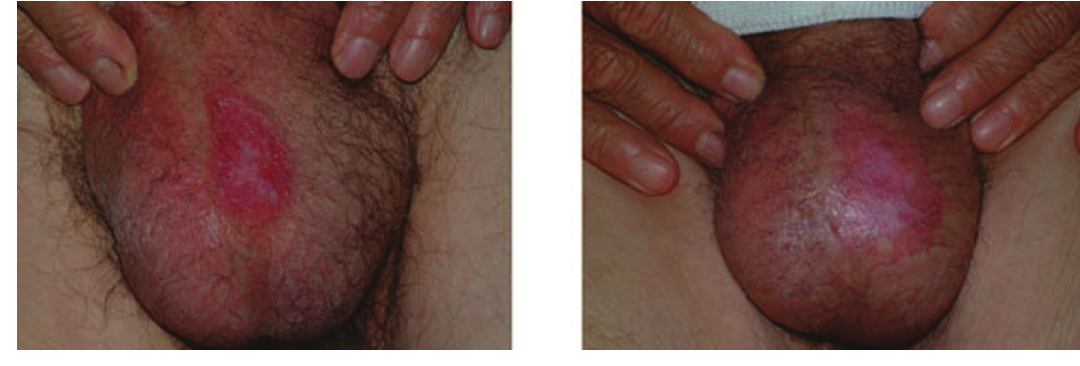
Figure 3 - Before and after PDT